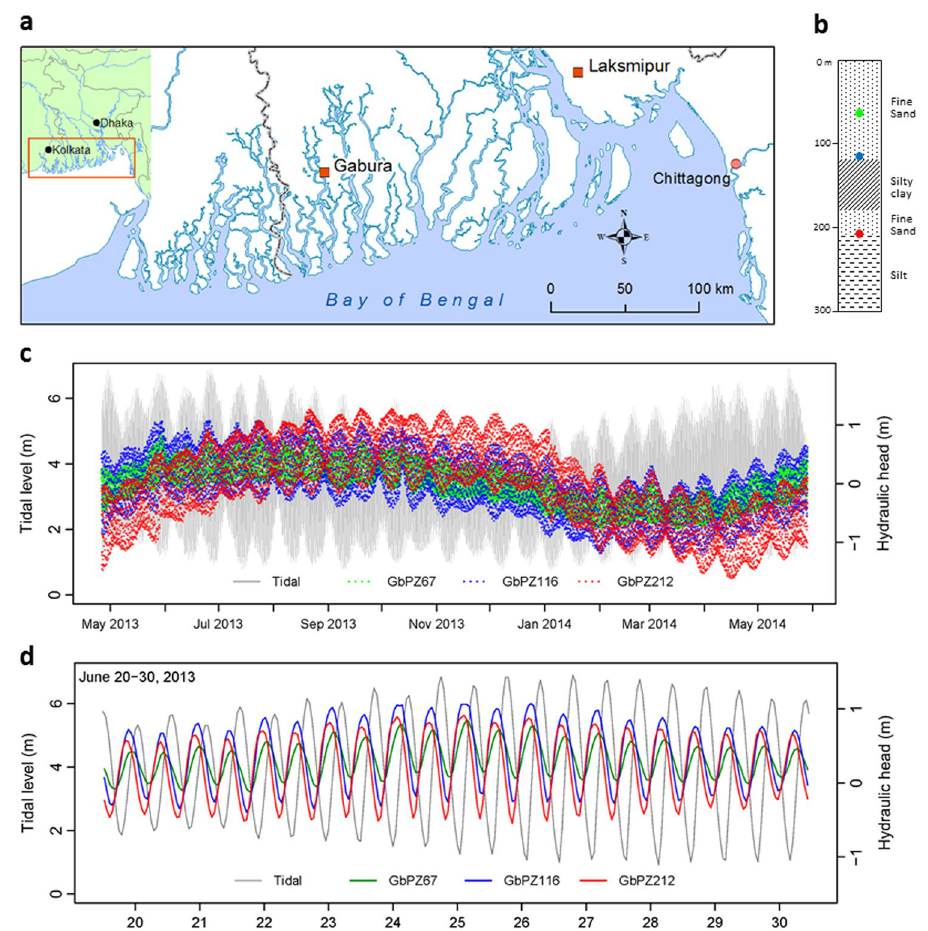
Figure 1. Study sites, hydraulic heads at Gabura and tide level at Chittagong, May 2013 to May 2014. ( a ) Location of the study sites (red squares) in southern Bangladesh (map created using ArcGIS version 10.3.1, https://www.arcgis.com/); ( b ) at Gabura, the open screen measurement points of piezometers GbPZ67 (green, depth 67 m), GbPZ116 (blue, depth 116 m), and GbPZ212 (red, depth 212 m) within the lithological profile; ( c ) the Gabura hydrographs from piezometers GbPZ67, GbPZ116, and GbPZ212 shown as equivalent fresh water head, and Chittagong tide level (grey), relative to the time series averages, May 2013 to May 2014; ( d ) the Gabura piezometer groundwater heads and the Chittagong tide, relative to the time series averages, 20 th June to 30 th June